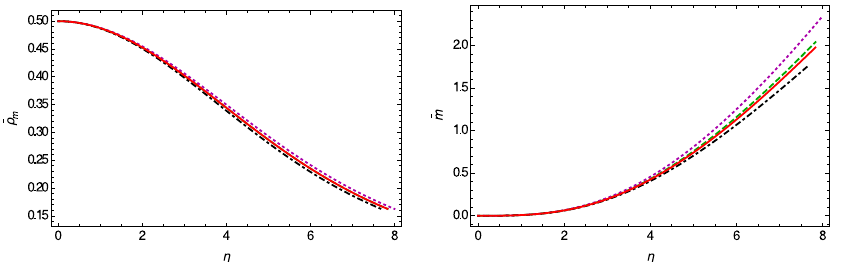
Fig. 15 Variation of the energy density ¯ ρ m (left panel) and of the mass ¯ m (right panel) in terms of η for three-form field quark stars in the presence of a constant field potential, for three different values of the constant ¯ λ : ¯ λ = 0 (dashed curve), ¯ λ = 0 . 02 (dotted curve), and ¯ λ = − 0 . 02 (dot-dashed curve), respectively. The central density of